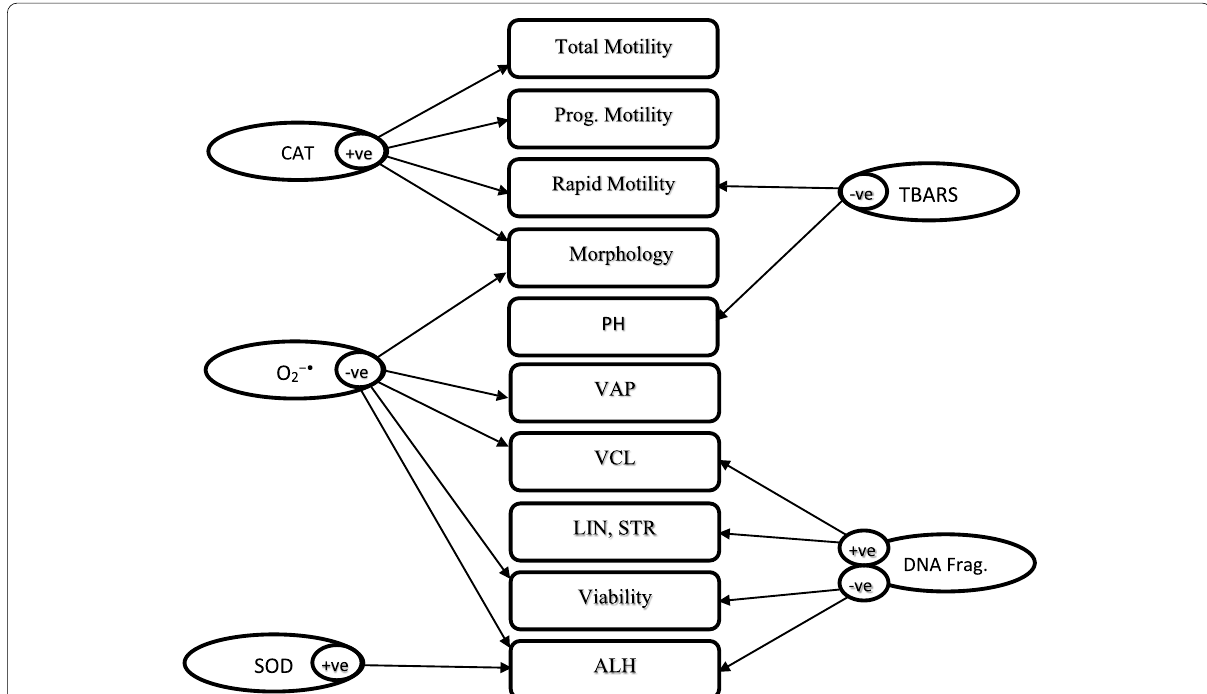
Fig. 1 Simplified schematic of the correlation between advanced and conventional semen parameters. O 2 − • (superoxide), TBARS (thiobarbituric acid reactive substances), SOD ( superoxide dismutase), CAT (catalase), VCL (curvilinear velocity), VSL (straight-line velocity), VAP (average path velocity), LIN (linearity), STR (straightness), ALH (amplitude of lateral head